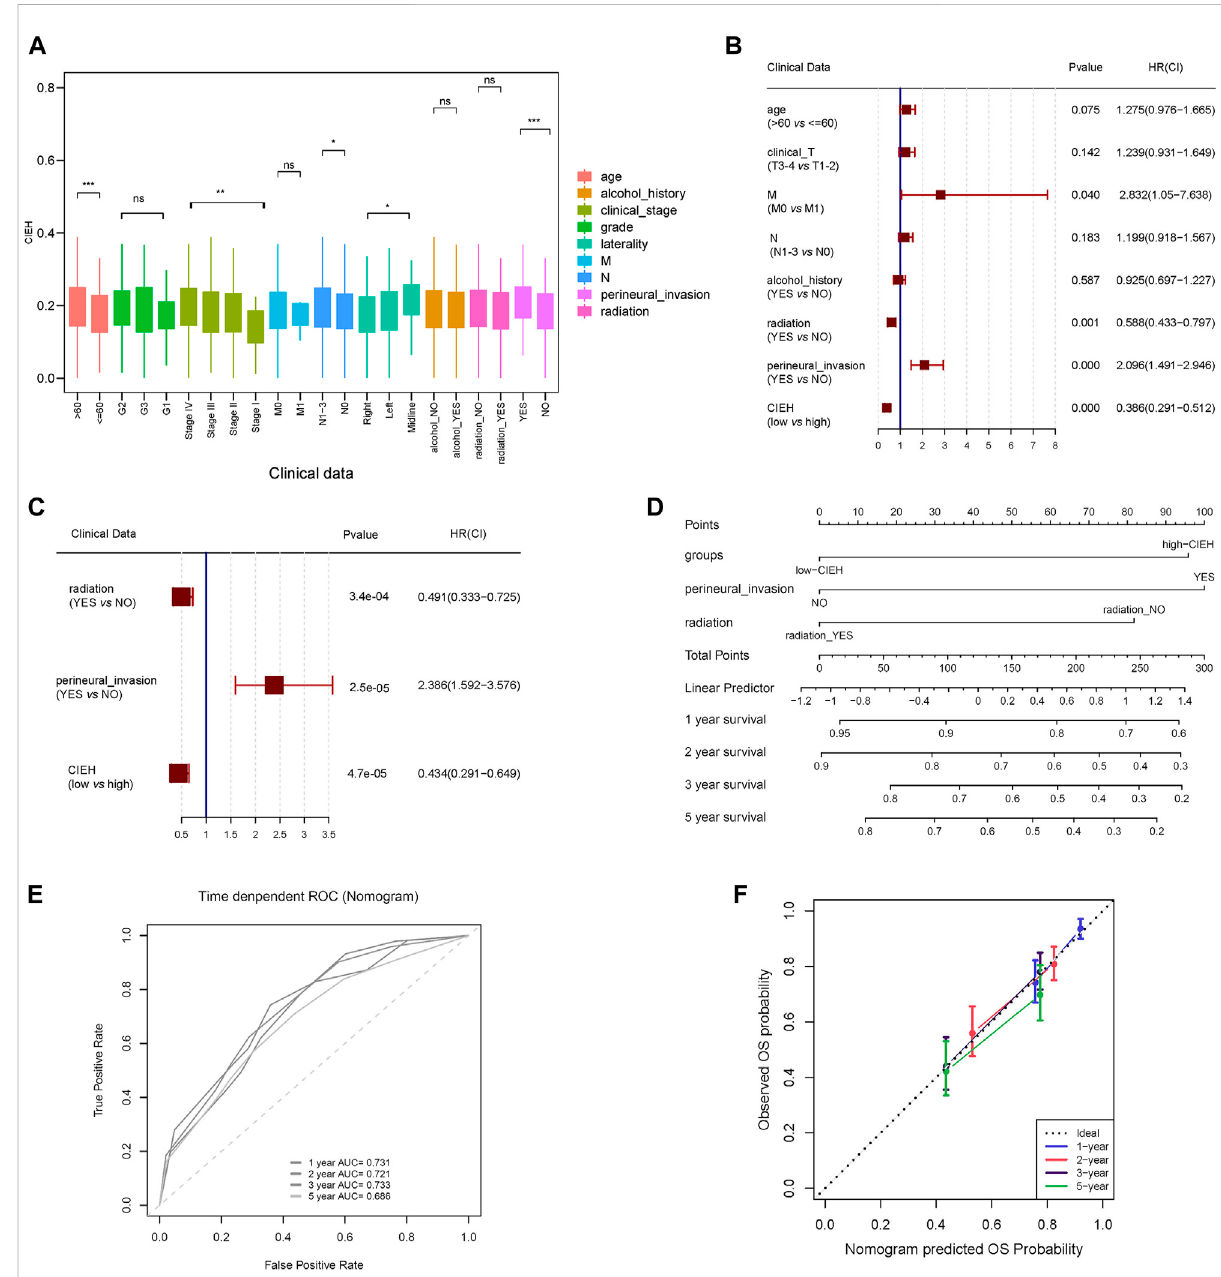
FIGURE 5 Clinical characteristics of CIEH. (A) . Difference analysis of CIEH model in clinical prognostic factors. (B) . Univariate Cox regression analysis of CIEH andother prognostic factors. (C) . Multivariate cox regression analysis ofCIEH and otherprognostic factors. (D) . Nomogram ofCIEHcombined with other prognostic factors to predict survival rate. (E) . ROC curve for predicting survival rate. 1-year AUC = 0.731; 2-year AUC = 0.721; 3-year AUC = 0.733; 5-year AUC = 0.686; (F) . Nomogram survival calibration curves at 1, 2, 3 and 5 years (C-indx =